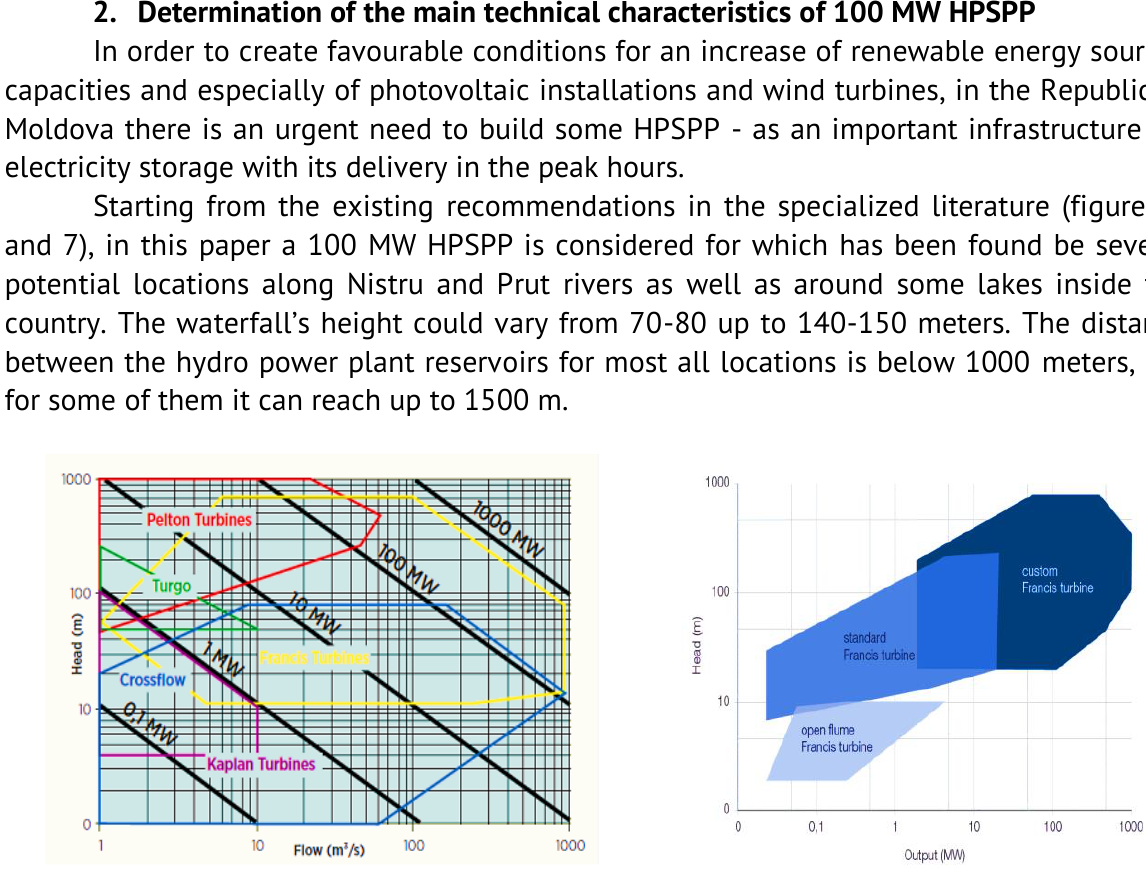
Figure 7. Operating range for Francis turbines [4].